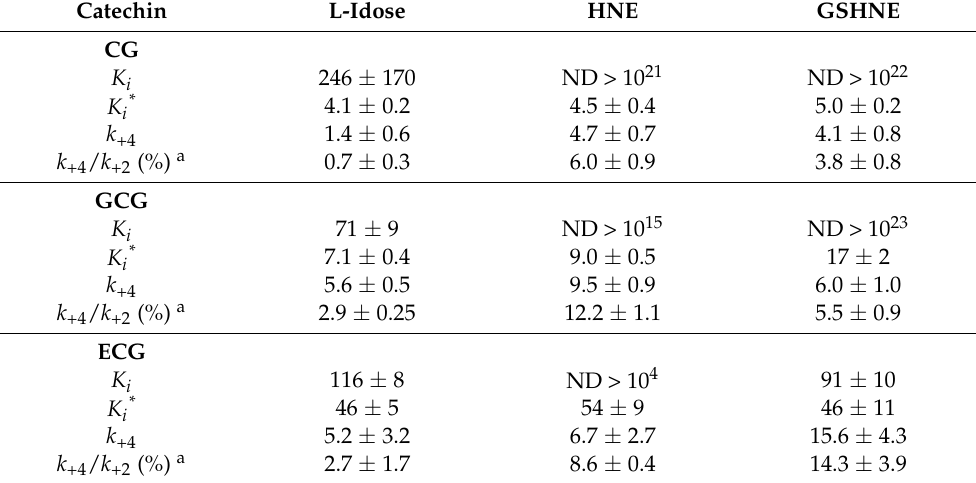
Table 1. Inhibition constants of CG, GCG, and ECG for L -idose, HNE, and GSHNE reduction. The values of the constants, derived from the non-linear regression analysis of 1/ app k cat , app K M , and app K app k cat versus [I] (Figures 4–6) through Equations (1)–(4). K i, and K M / is expressed in min − 1 . The K M values for L-idose, HNE, and GSHNE in the absence of inhibitors were assumed 4260 µ M, 51 µ M, and 120 µ M, respectively. Data are reported as the mean ± SD; ND: not determined. a Calculated using k +2 values of 195 ± 6 min − 1 , 78 ± 4 min − 1 , and 109 ± 8 min − 1 for L-idose, HNE, GSHNE,